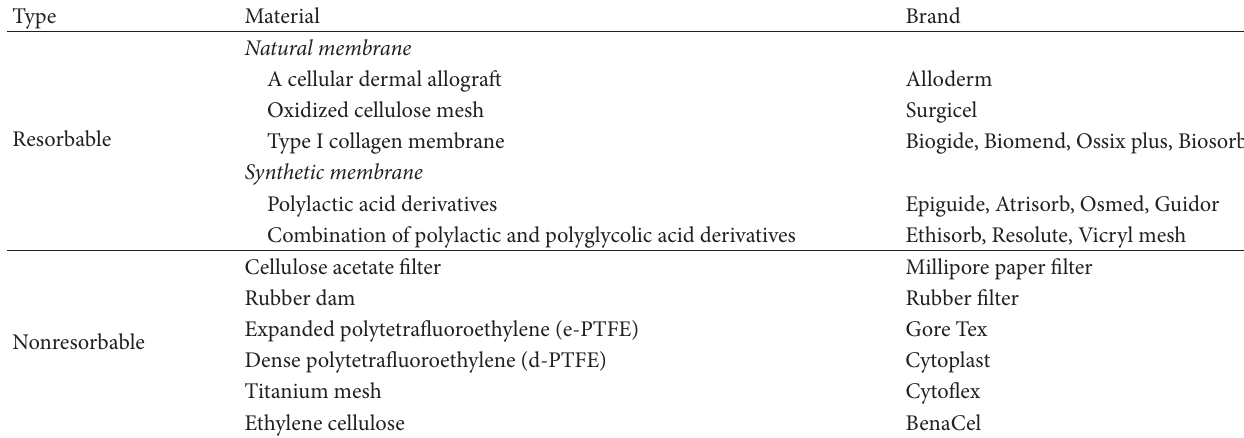
Table 1: Types of barrier membrane in periodontal regeneration.